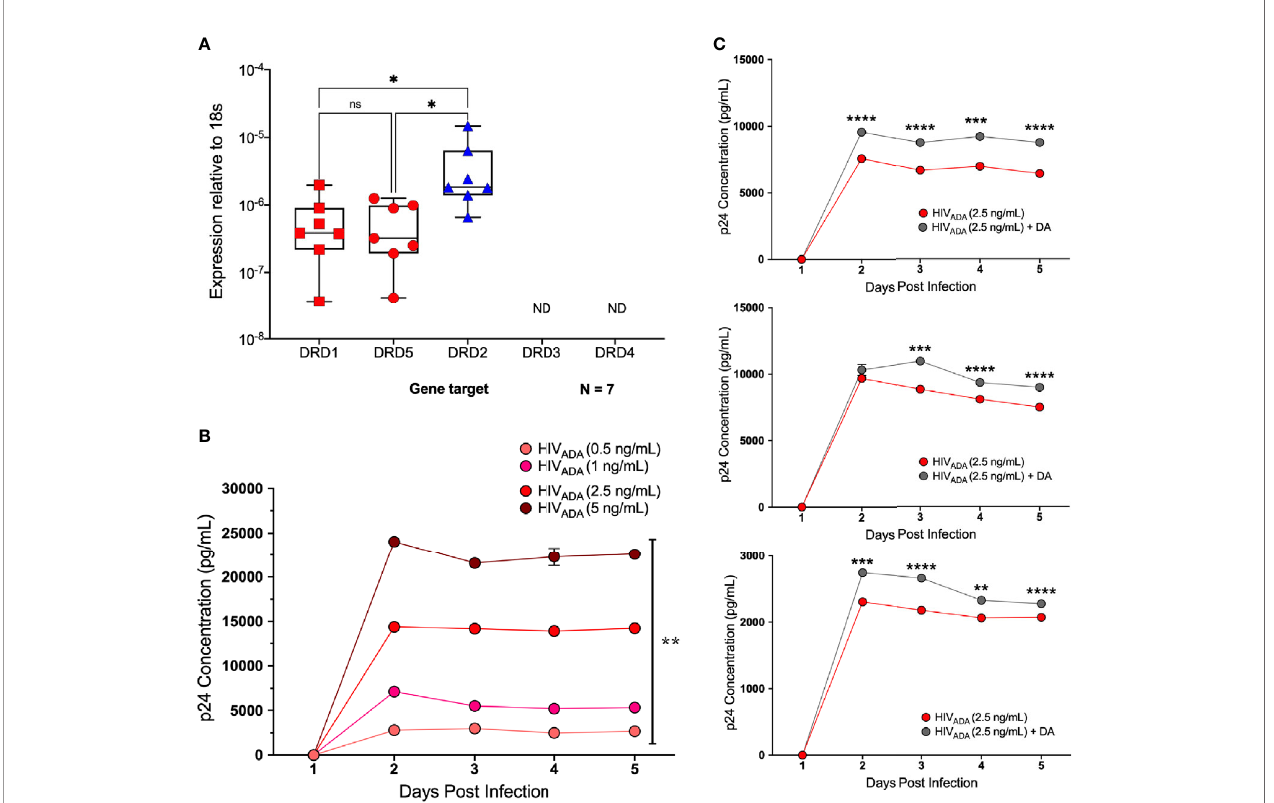
FIGURE 7 | C06 human microglia are infectable with HIV and dopamine increases HIV replication. (A) Quantitative RT-PCR detected mRNA for DRD1, DRD2, and DRD5 in C06 cells (N=7), and DRD2 expression is higher compared to DRD1 and DRD5 (Kruskal-Wallis test, n = 7, **p = 0.0048, Dunn ’ s multiple comparisons test, DRD1 vs. DRD2, *p = 0.0331, DRD5 vs DRD2, *p=0.0175). (B) C06 cells were infected with a range of concentrations of HIV ADA (0.5, 1, 2.5, and 5 ng/ml) for 5 days, and analysis of p24 levels shows signi fi cant changes in response to different infection levels at each day post-infection (rmANOVA, Day 2, ****p<0.0001, F (1.208, 2.417) = 2992, HIV 0.5 SEM=16.05, HIV 1 SEM=49.75, HIV 2.5 SEM=199.2 HIV 5 SEM=223.17; Day 3, ****p<0.0001, F (1.270, 2.539) = 2429, HIV 0.5 SEM=23.36, HIV 1 SEM=125.7, HIV 2.5 SEM= 241.63, HIV 5 SEM=171.17; Day 4, **p= 0.0031, F (1.024, 2.047) = 292, HIV 0.5 SEM=122.89, HIV 1 SEM=60.18, HIV 2.5 SEM=147.54, HIV 5 SEM=983.1; Day 5, ***p= 0.0004, F (1.052, 2.104) = 1825, HIV 0.5 SEM=42.66, HIV 1 SEM=52.72, HIV 2.5 SEM=31.0, HIV 5 SEM=417.7). (C) Representative p24 analysis in 3 C06 passages demonstrating increased HIV replication in dopamine-treated (10 -6 M), HIV infected (HIV ADA 2.5 ng/ ml) cells compared to cells only infected with HIV (multiple t-tests corrected for multiple comparisons using the Holm-Sidak method, top infection: Day 2, ****p < 0.0001, t=13.47, df=4, HIV SEM=132.0, HIV + DA SEM=67.31; Day 3, ****p < 0.0001, t=26.19, df=4, HIV SEM=47.06, HIV + DA SEM=63.88; Day 4, ***p = 0.0018, t=7.355, df=4, HIV SEM=294.12, HIV + DA SEM=84.26; Day 5, ****p < 0.0001, t=18.51, df=4, HIV SEM=114.5, HIV + DA SEM=53.27; middle infection: Day 2, p > 0.05, HIV SEM=63.46, HIV + DA SEM=414.56; Day 3, ***p =0.0002, t=12.96, df=4, HIV SEM=89.97, HIV + DA SEM=137.34; Day 4, ****p < 0.0001, t=18.84, df=4, HIV SEM=17.89, HIV + DA SEM=64.83; Day 5, ****p < 0.0001, t=28.65, df=4, HIV SEM=37.37, HIV + DA SEM=36.39; bottom infection: Day 2, ***p=0.0002, t=12.95, df=4, HIV SEM=27.99, HIV + DA SEM=19.09; Day 3, ****p < 0.0001, t=26.98, df=4, HIV SEM=3.3, HIV + DA SEM=17.64; Day 4, **p = 0.009, t=4.743, df=4, HIV SEM=26.47, HIV + DA SEM=49.53; Day 5, ****p < 0.0001, t=18.35, df=4, HIV SEM=4.94, HIV + DA SEM=9.99). ns, not signi fi